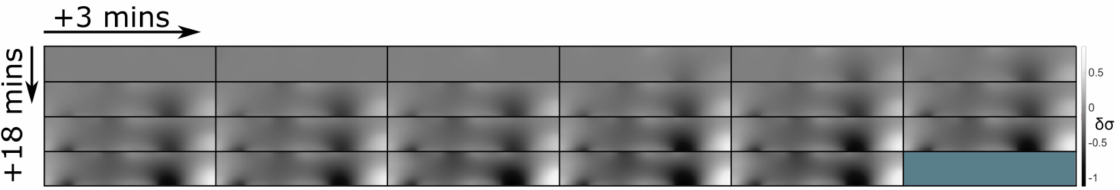
Figure 8. Sample SB5 tomographic reconstruction over time: each rectangle in the grid represents a single tomographic impedance difference image against the initial state. Each image frame represents the passing of 3 minutes in time.